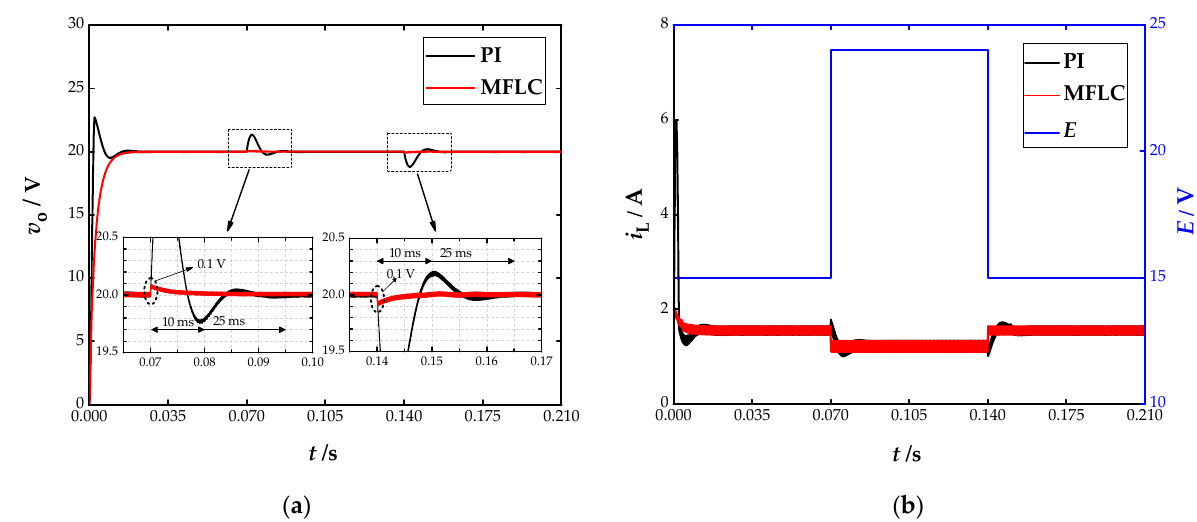
Figure 5. The response of the buck-boost converter when the input voltage E changes suddenly at 0.07 and 0.14 s, respectively. ( a ) Response curve of the output voltage v o ; ( b ) Response curve of the input current i L .